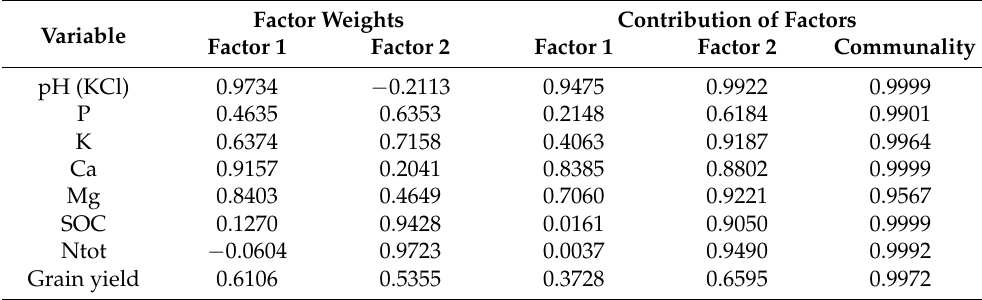
Figure 5. The results of the factor analysis showing the relationship between ( a ) soil properties and grain yield and ( b ) fertilizer treatment/locality. Table 6. Factor weights and contributions of a given factor to the communality for individual characters after normalized Varimax rotation for production (yield) and soil parameters.